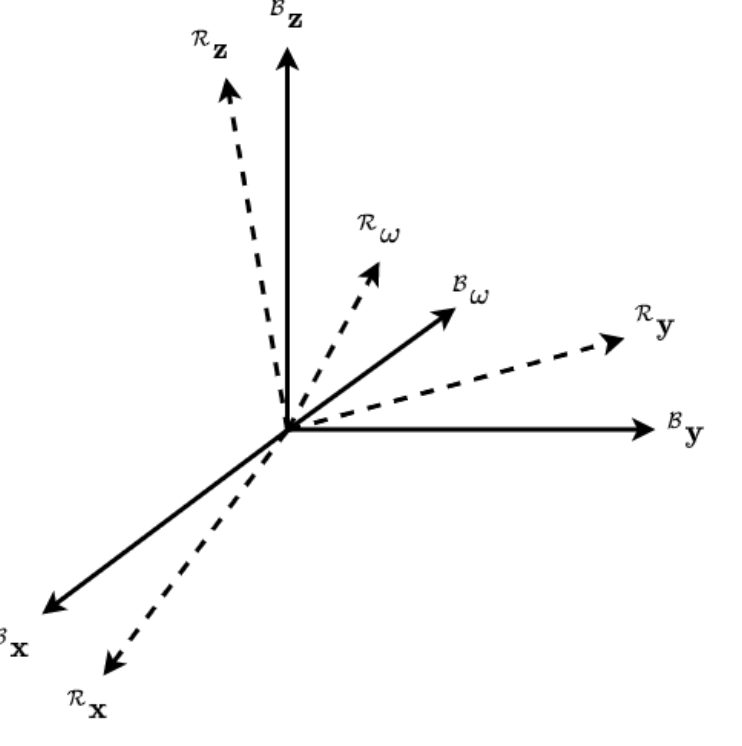
Figure 5. The body and reference frames and angular velocities shown in